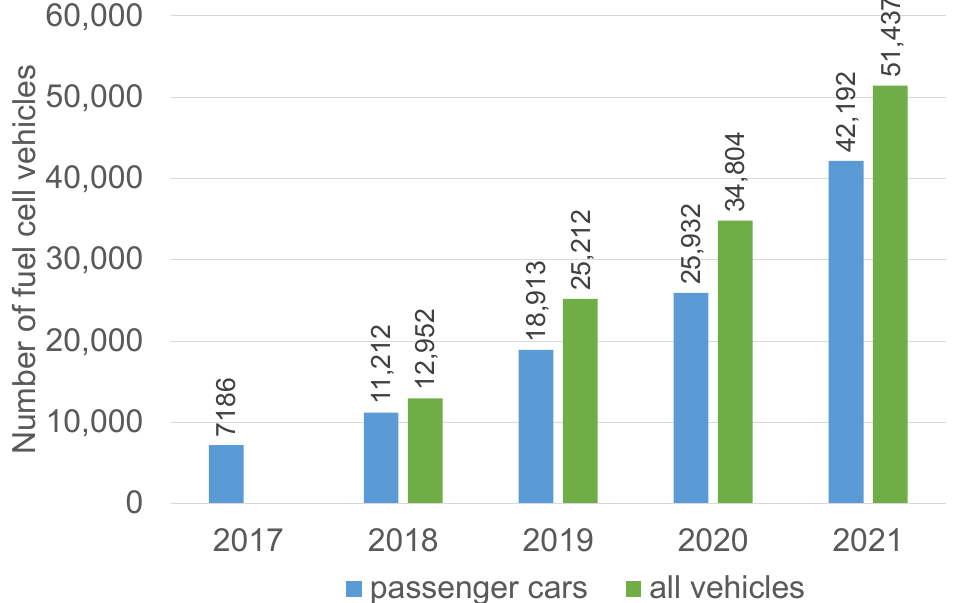
Figure 10. Development of the number of fuel cell vehicles based on results from previous surveys and this work.